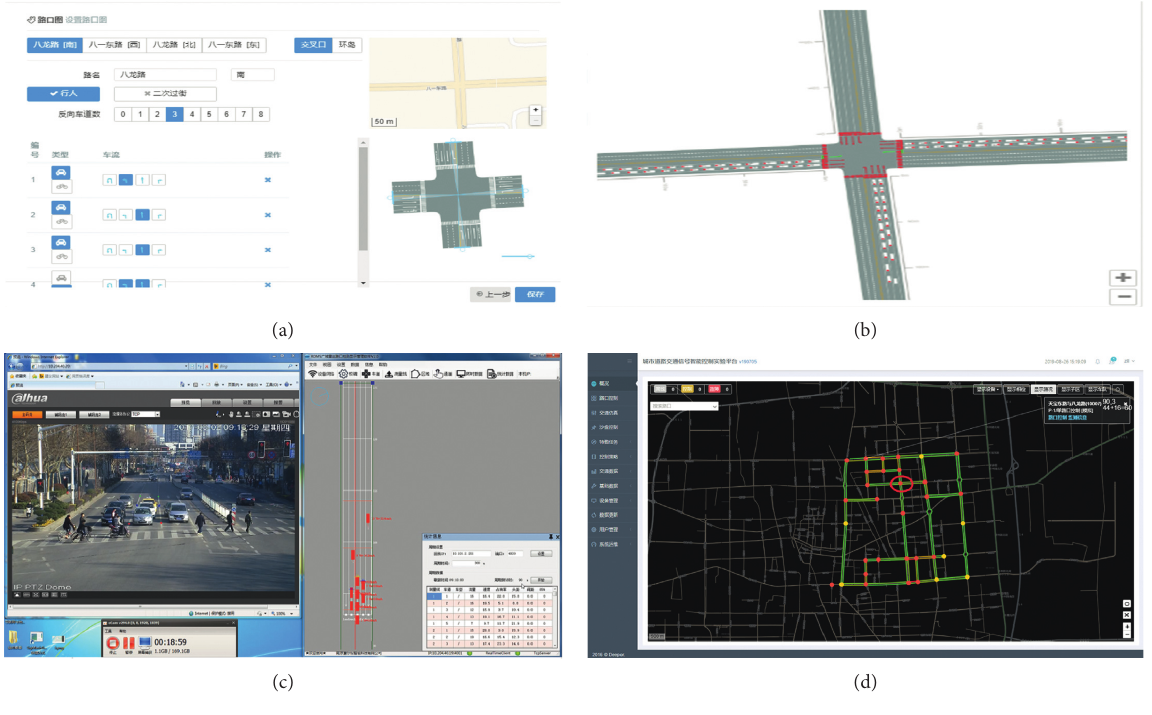
Figure 9: Balong road intersection in Xuchang city.